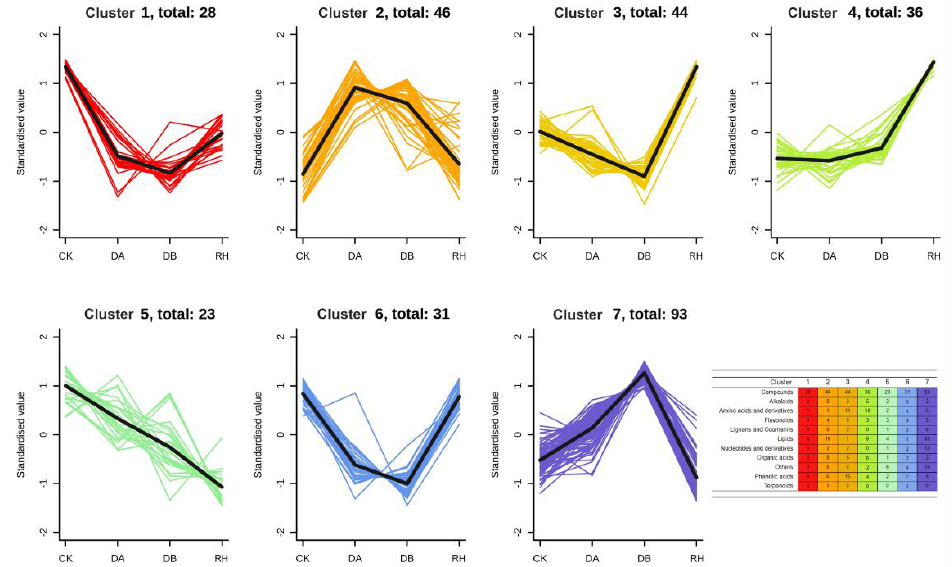
Figure 5. K-means cluster analysis of the metabolites that were grouped into seven clusters according to their expression pattern under the different treatments. The x-axis corresponds to the control (CK), 15-day drought treatment (DA), 30-day drought treatment (DB), and rehydration (RH) groups. The y-axis corresponds to the standardised value. Data were plotted using the prcomp function in R software with default settings [24]. The amount in each category of compounds among seven clusters was indicated in the lower right pane.